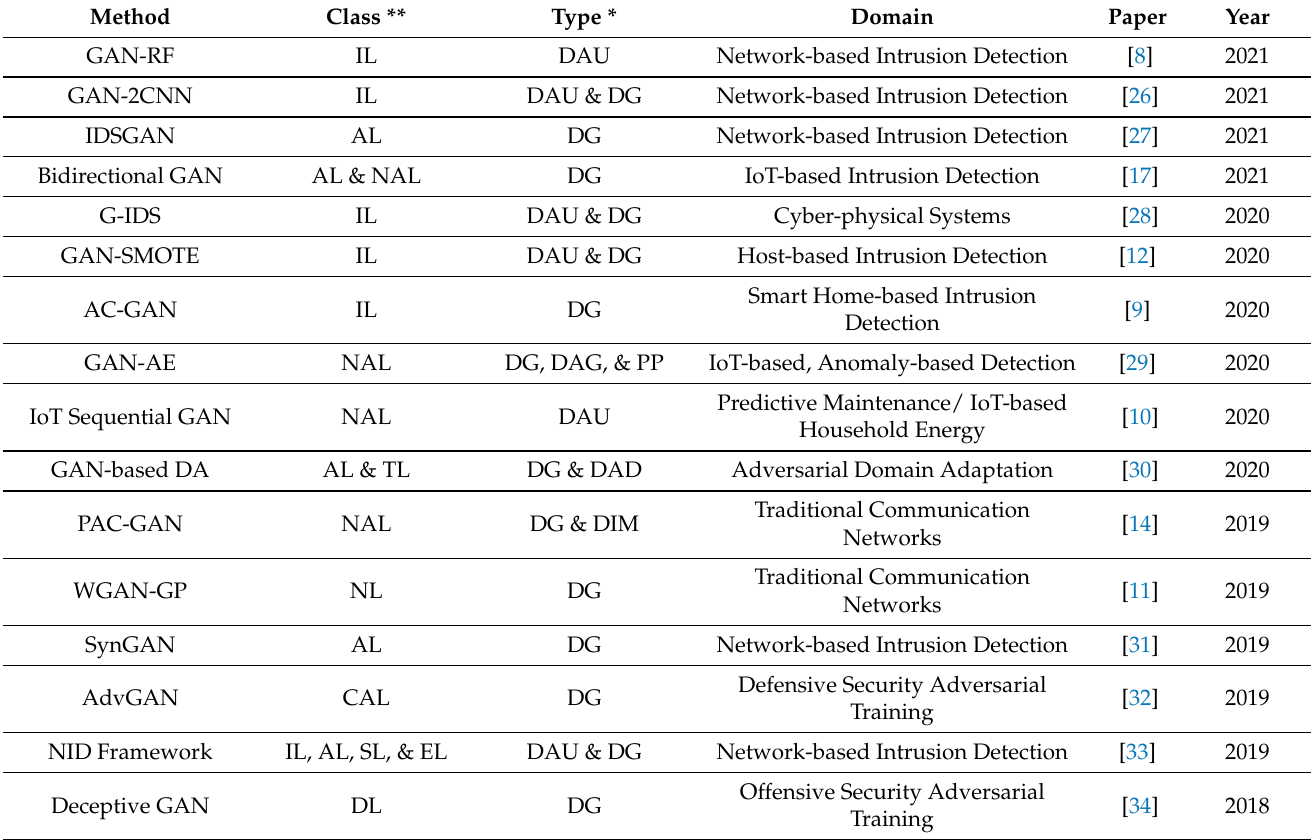
Table 2. Classification of Data-driven Learning